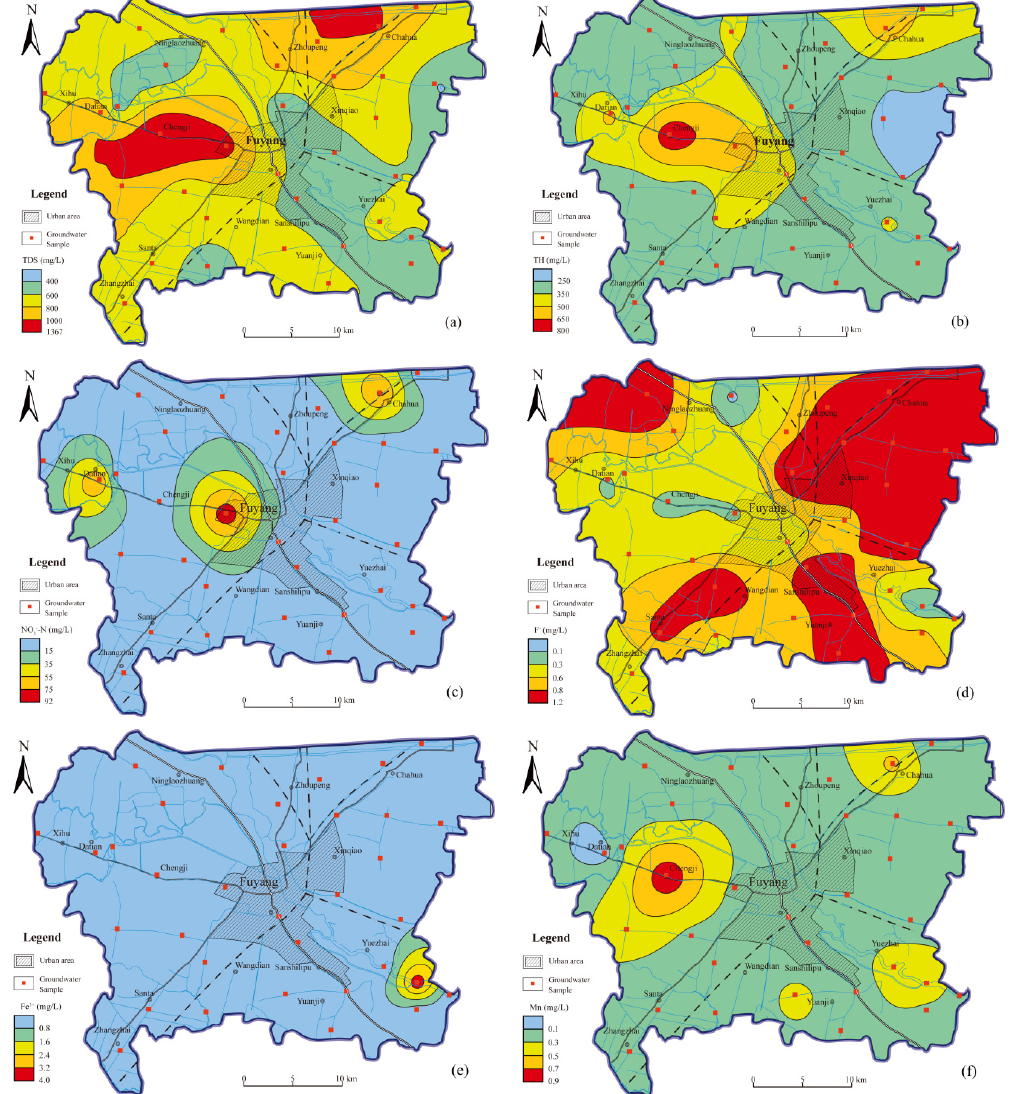
Figure 3. Spatial distribution of contaminants in groundwater: ( a ) TDS, ( b ) TH, ( c ) NO 3 -N, ( d ) F − , ( e ) Fe 3 + , and ( f )